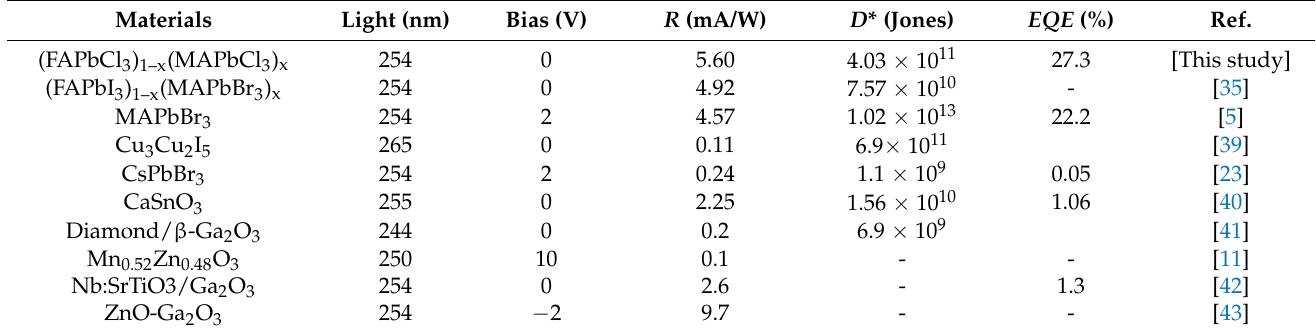
Table 1. Parameter comparison of UVC photodetectors based on various halide